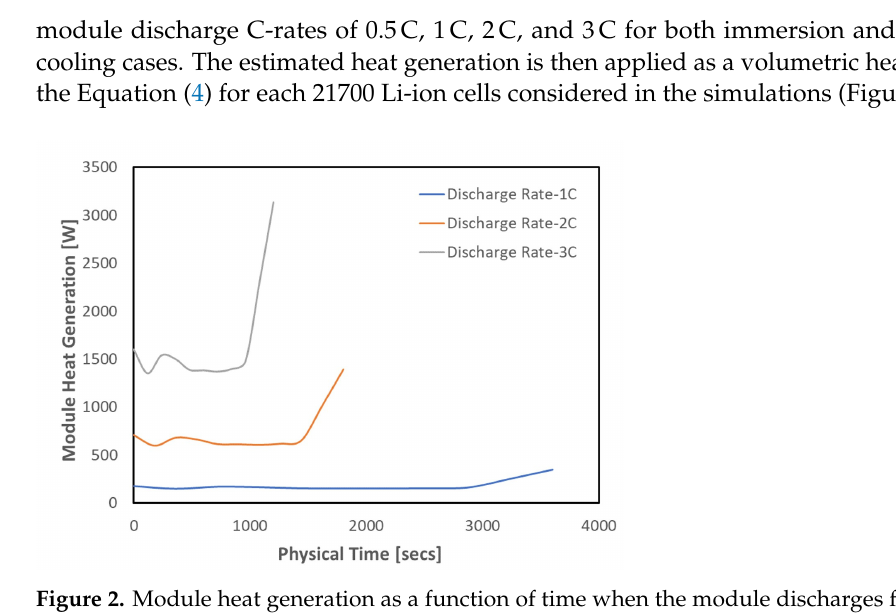
Figure 2. Module heat generation as a function of time when the module discharges from SOC of 100% to 0% at different C-rates.